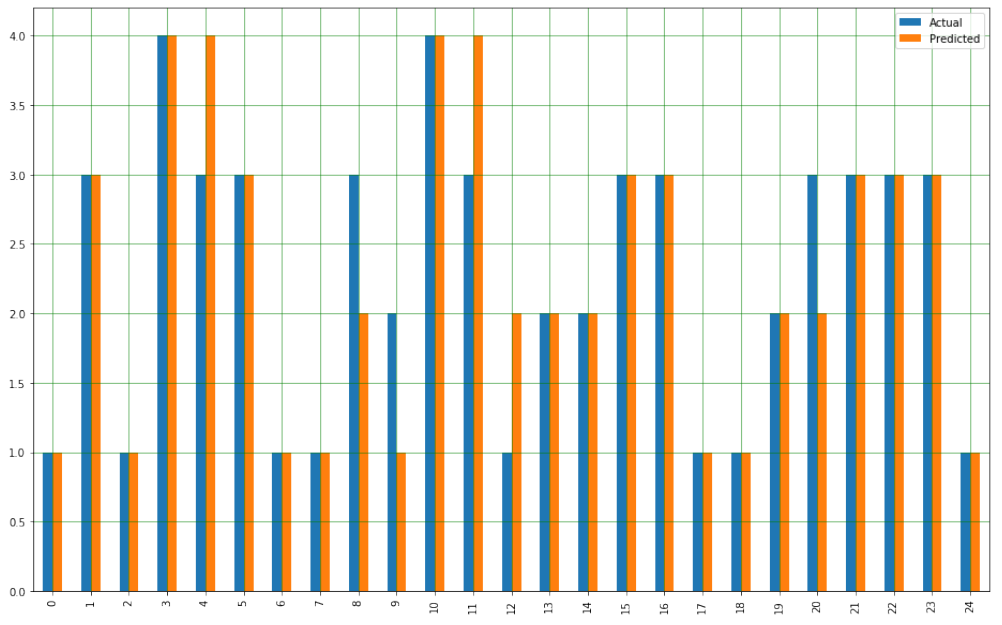
Figure 11. Actual vs. predicted values.